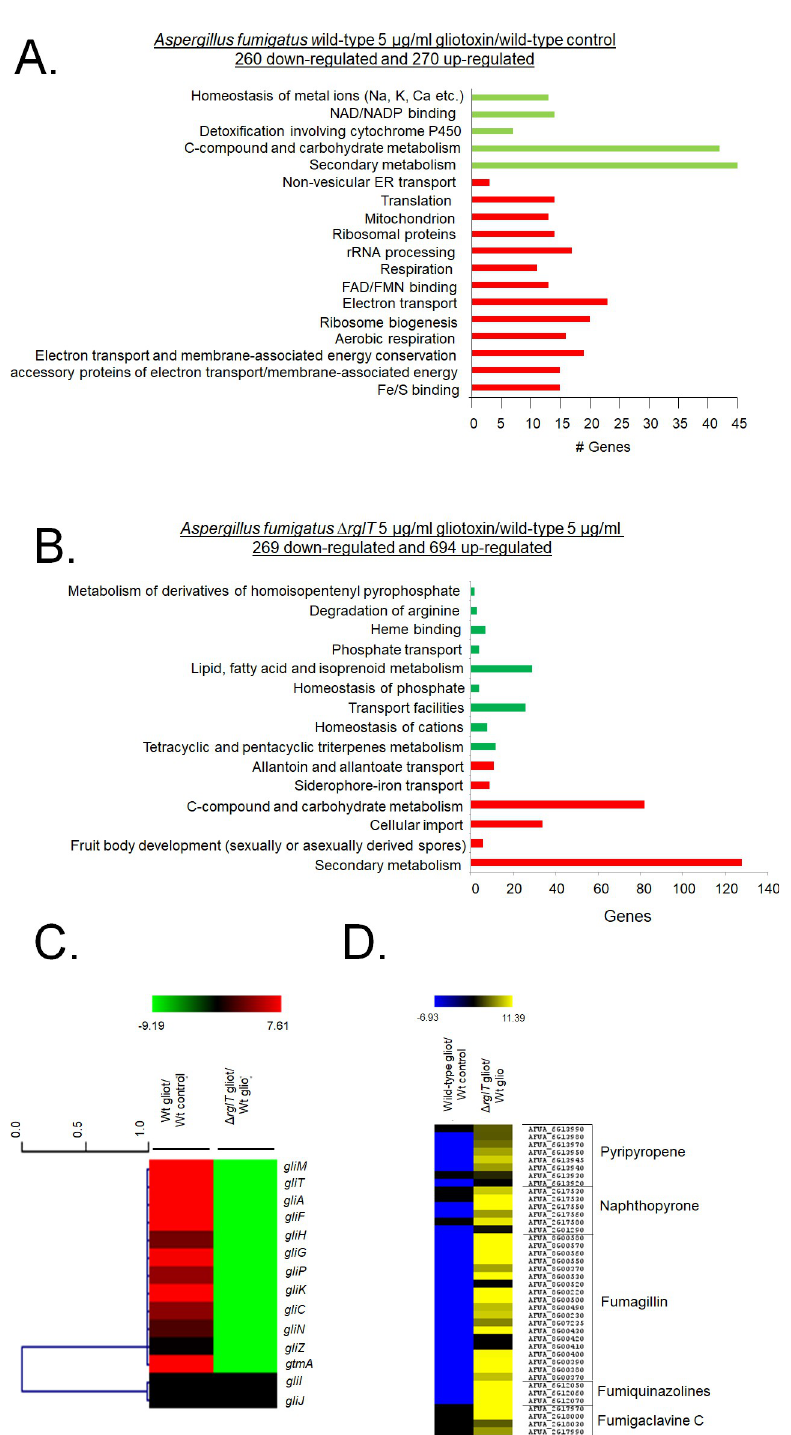
Fig 1. Functional characterisation (FunCat) of significantly differently expressed genes (DEGs) identified by RNA-sequencing in the A . fumigatus Δ rglT strain. (A) FunCat analysis of DEGs up-regulated in the A . fumigatus wild-type and in (B) Δ rglT strain in comparison to the wild-type (WT) strains when exposed to 5 μ g/ml GT for 3 h. (C) Heat map depicting the log2 fold change (Log2FC) of differentially expressed genes (DEGs), as determined by RNA- sequencing, and encoding enzymes present in the GT BGC required for GT biosynthesis. The gene gtmA was also included in this heat map. (D) Heat map depicting the Log2FC of differentially expressed genes (DEGs), as determined by RNA-sequencing, and encoding enzymes required for secondary metabolite (SM) biosynthesis. In both (C) and